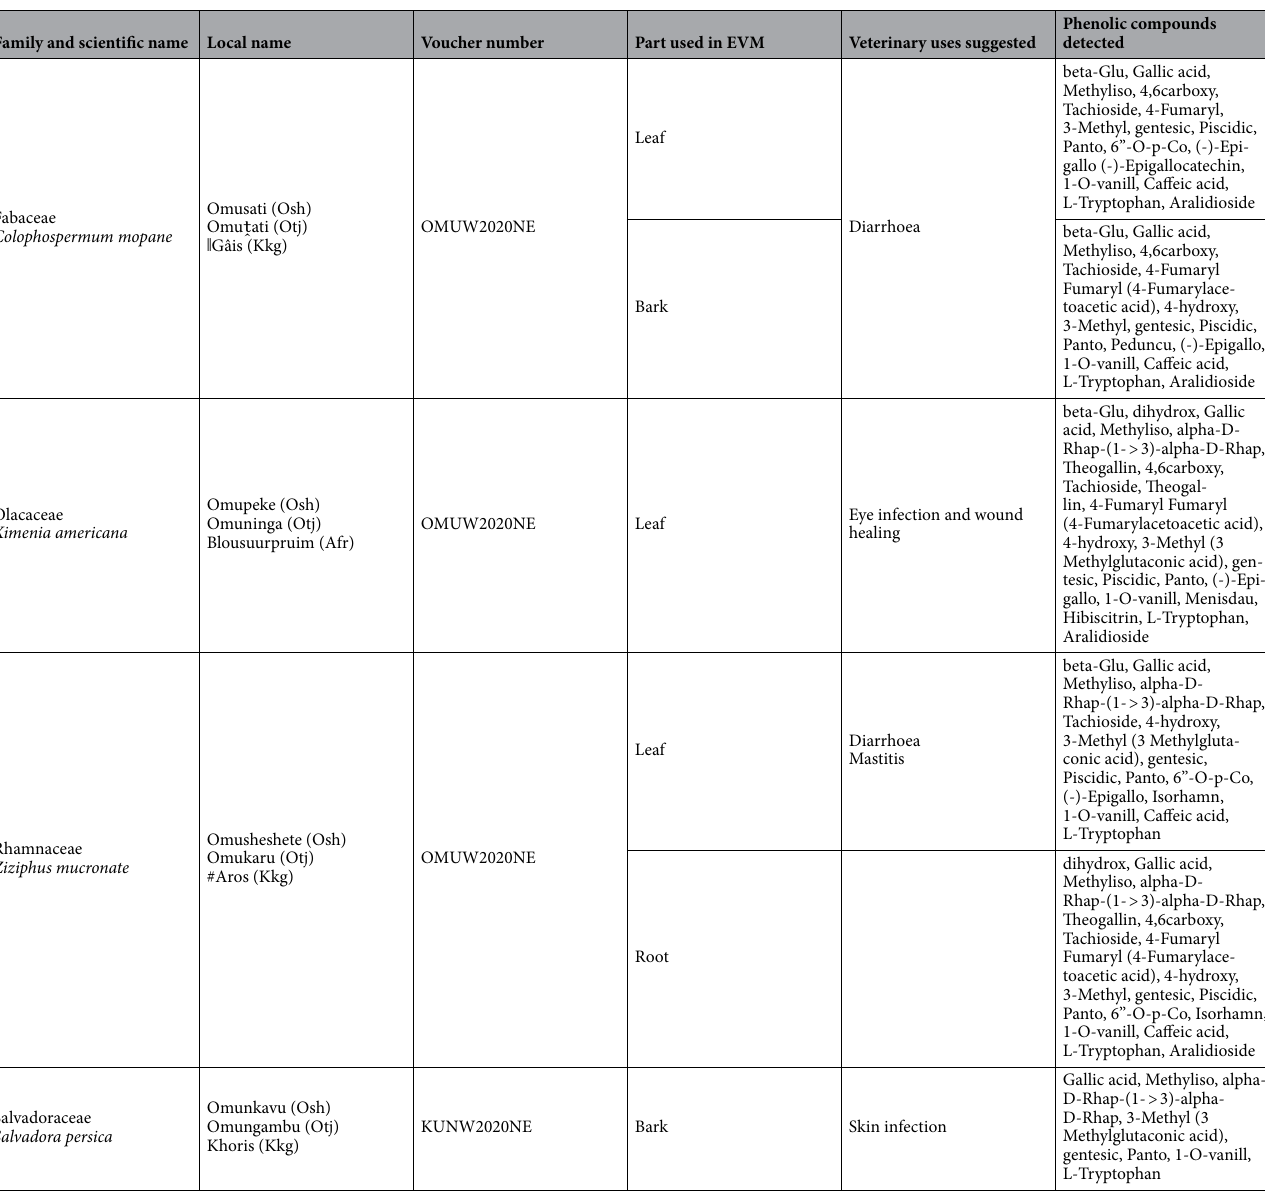
Table 1. Medicinal properties of the plant species